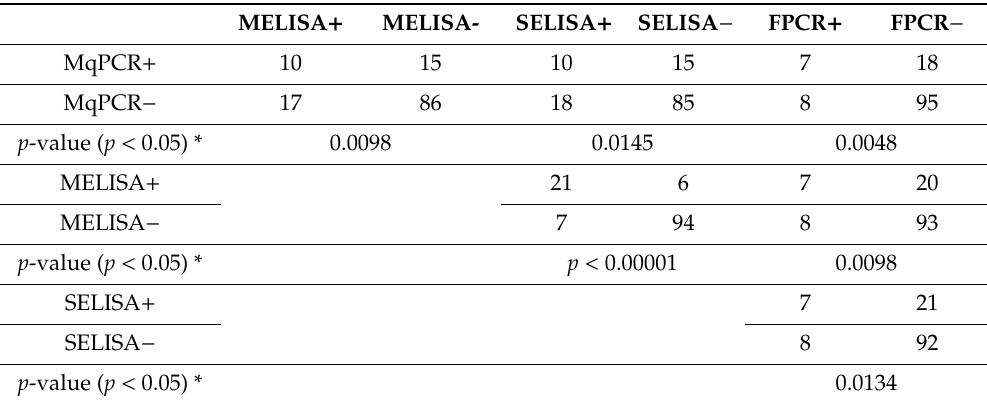
Table 7. Chi-square analysis and the distribution of 128 MIF milk samples classified into 24 binary groups based on the positive / negative status in MqPCR, MELISA, SELISA, and FPCR and corresponding p -values. MELISA + MELISA- SELISA + SELISA − FPCR + FPCR − MqPCR + 10 15 10 15 7 18 MqPCR − 17 86 18 85 8 95 0.0098 0.0145 0.0048 MELISA + 21 6 7 20 MELISA − 7 94 8 93 0.0098 SELISA + 7 21 SELISA − 8